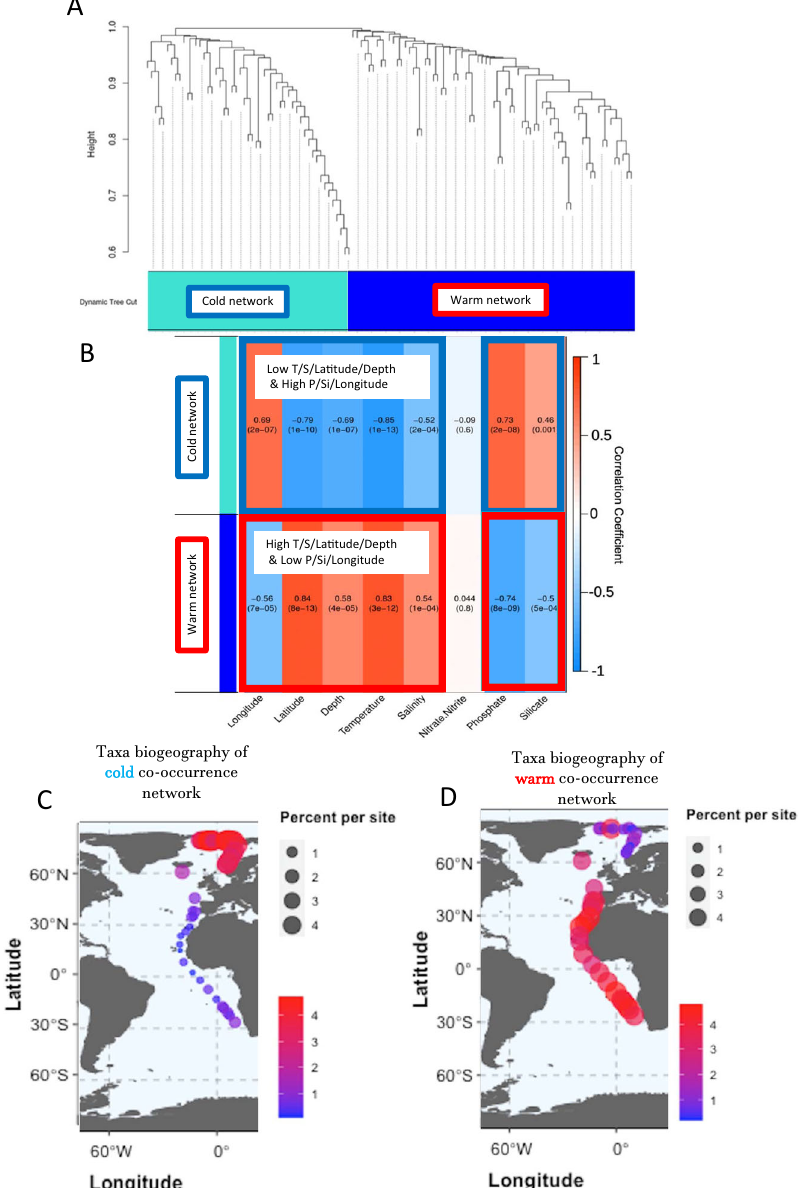
Fig. 4 Co-occurrence networks of 16 and 18S rDNAs, their biodiversity and biogeographical mapping of the node-speci fi c abundance for each taxonomic network across all stations from pole to pole. On the log10 transformed abundances of 18S rDNA species level and 16S rDNA genus level, two networks were found: A cold ( n = 51) and warm (n = 70). A list of species names and class names of the species can be found in the Supplementary Table 2. B Co-occurrence analysis of 18S rDNA species level and 16S rDNA genus level, two networks were found, a turquoise (cold) and blue (warm). Correlation heatmap between the networks and environmental parameters. The colours correspond to the correlation values, red is positively correlated and blue is negatively correlated. The values in each of the squares correspond to the assigned Pearson correlation coef fi cient value on top and p -value in brackets below. C Taxa biogeography of cold 16/18S co-occurrence network. D Taxa biogeography of warm 16/18S co-occurrence network. Abundance is given in percentage contribution to the total sequence pool per site with increasing contribution from small to large circles and from blue to